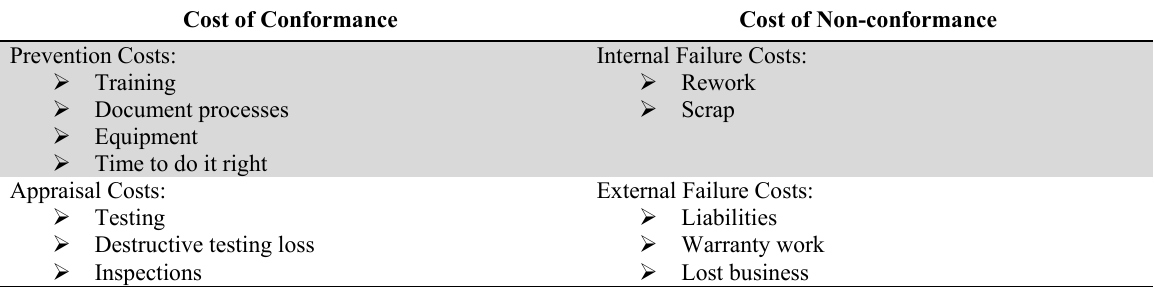
Cost of quality (Project Management Institute,